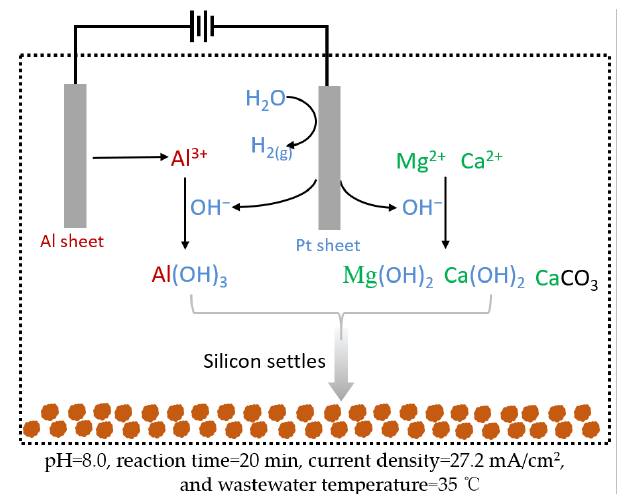
Figure 5. Silicon removal mechanism of electrocoagulation.